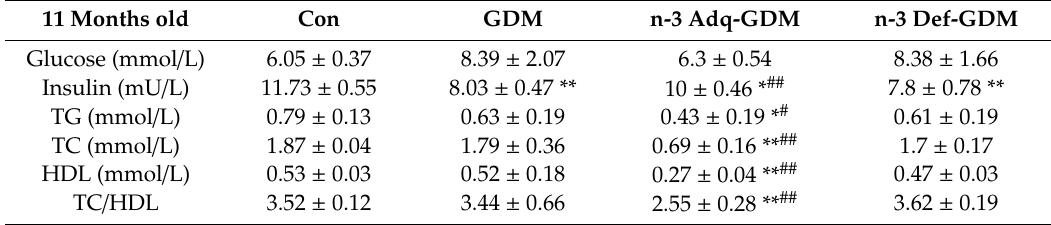
Table 2. biochemical index of GDM offspring at 11 months of age and n-3 polyunsaturated fatty acids Table 2. Biochemical index of GDM o ff spring at 11 months of age and n-3 polyunsaturated fatty acids (n-3 PUFA) effect. ( n -3 PUFA) e ff ect.